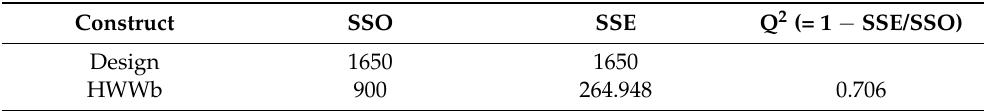
Table 12. Q-Square